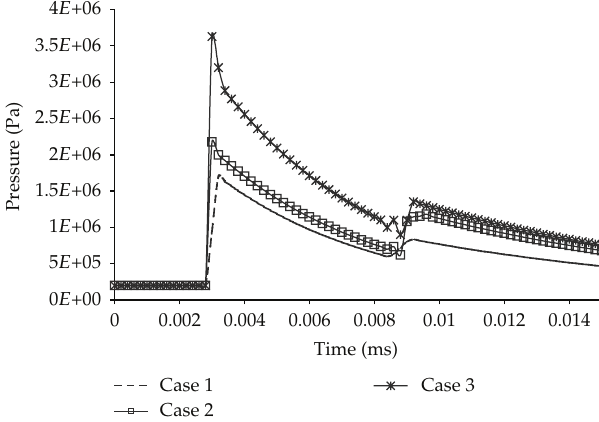
Figure 6: Pressure evolution as function of time with hydrogen mass fraction cases.